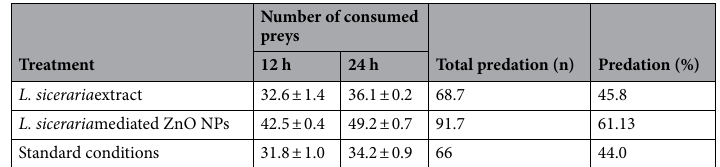
Table 2. Predation efficiency of the Poecilia reticulata against III instar larvae of Anopheles stephensi.